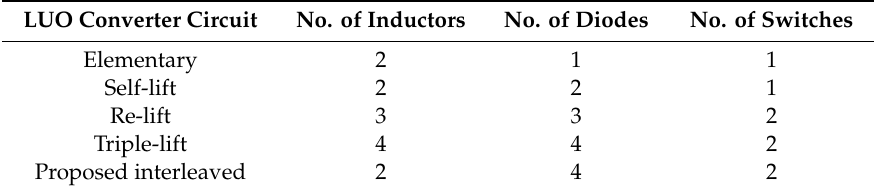
Table 2. Comparison of proposed Luo converter components with different Luo converter structures. LUO Converter Circuit